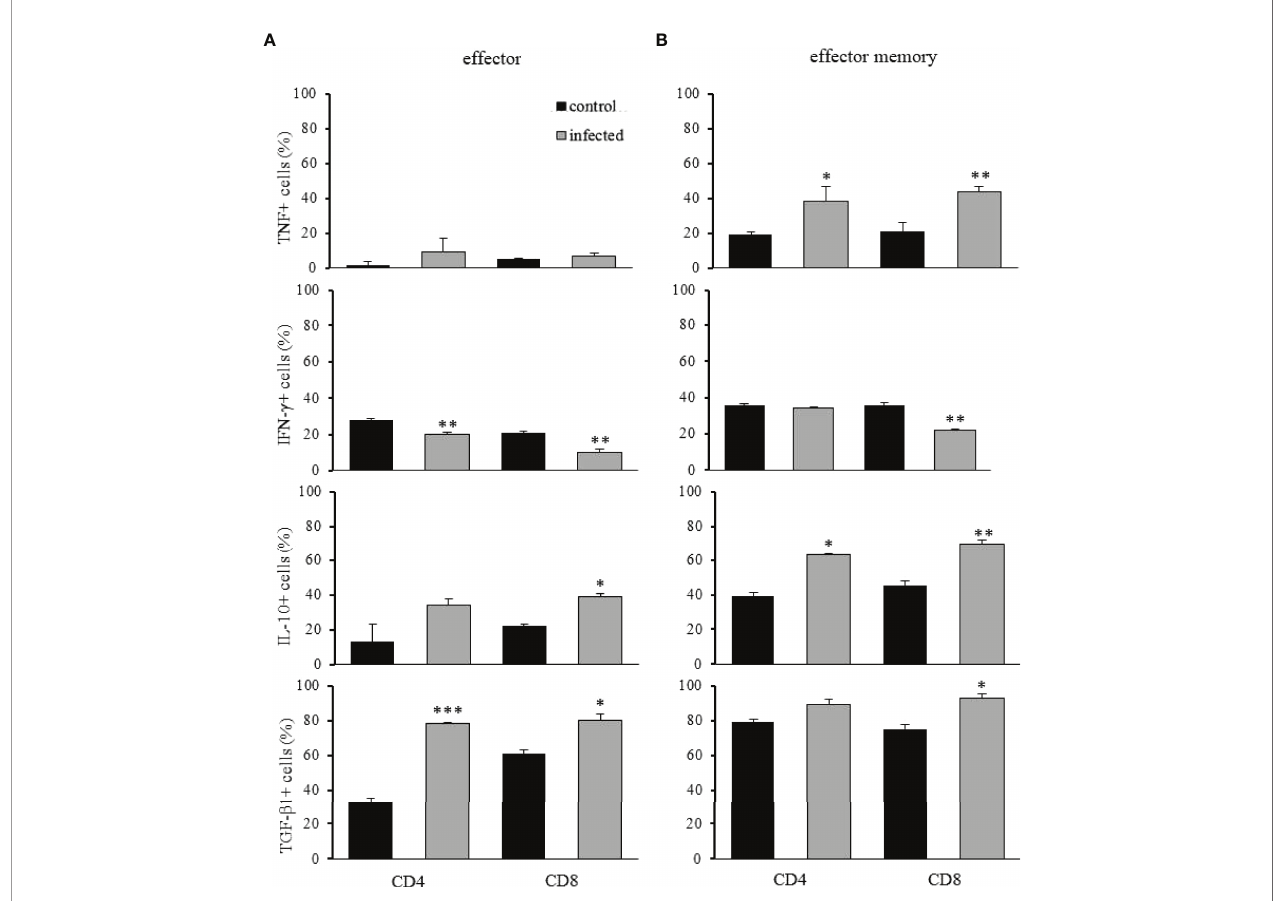
FIGURE 6 | Pro- and anti-in fl ammatory cytokines produced by effector and effector memory T lymphocytes after T. cruzi infection. The analysis of TNF- a , IFN- g , IL-10, and TGF- b 1 positive CD4 + or CD8 + intrahepatic T lymphocytes are shown as indicated. The cellular frequency of effector and effector memory T cells was evaluated in control and infected mice on dpi 15. * means p ≤ 0.05, ** means p ≤ 0.005, and *** means p ≤ 0.001 using the one-way ANOVA test followed by the Tukey ’ s